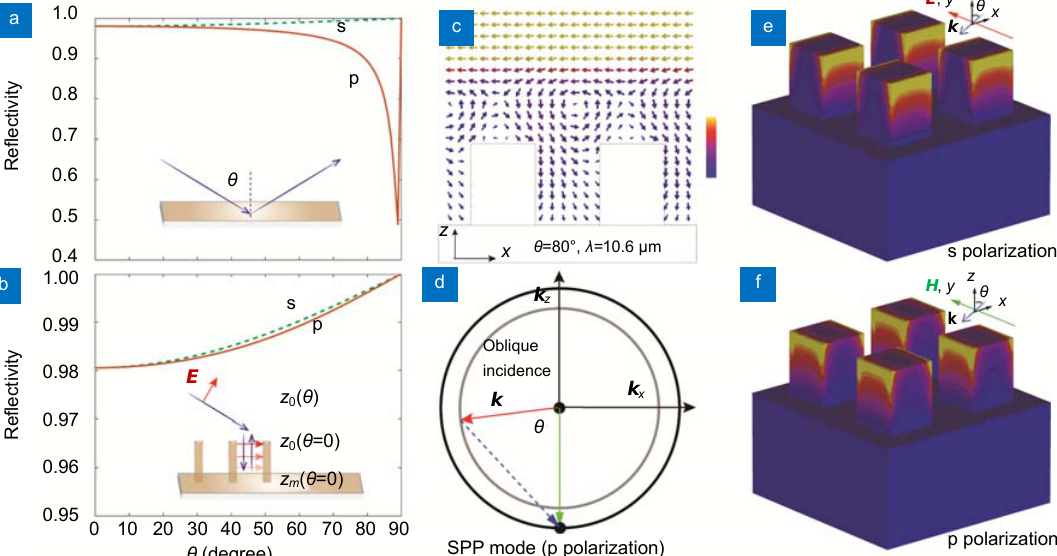
Fig. 2 | Theoretical analysis of the metallic grating. ( a ) Reflectance of s- and p-polarized light for a smooth gold plate. ( b ) Reflectance of s- and p-polarized light for a gold plate decorated with subwavelength posts array. ( c ) Energy flow in the xz -plane when p-polarized light is incident with a angle of 80°. ( d ) Schematic of the wavevector mismatching at the air-posts interface. ( e ) and ( f ) Amplitudes of the electric fields for s- and p-polarization at θ